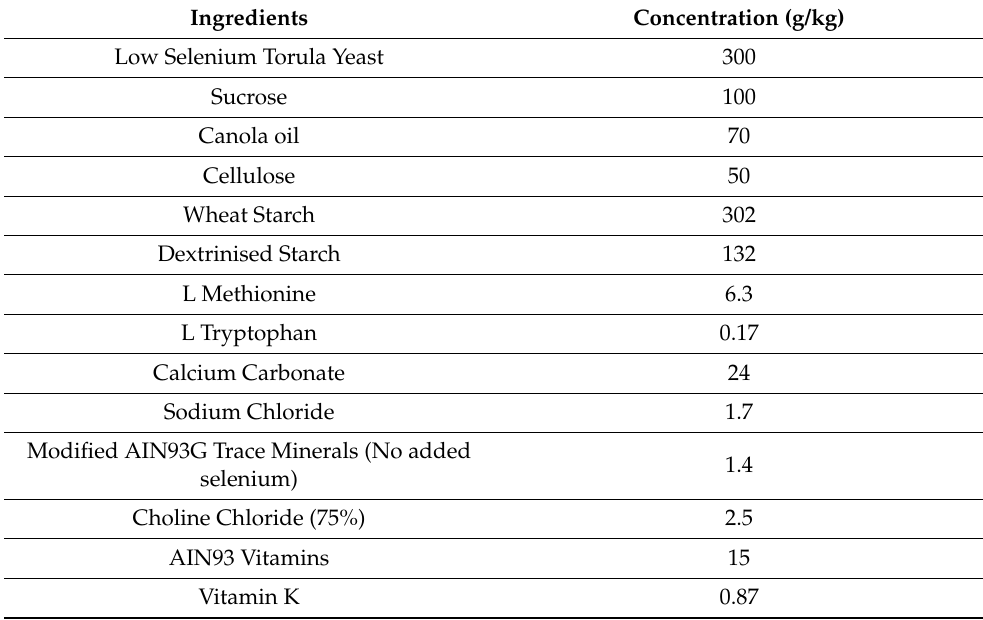
Table 1. Composition of the modified AIN-93G diet sourced from Speciality feeds (low selenium Torula yeast extra vitamins semi-pure rodent diet;